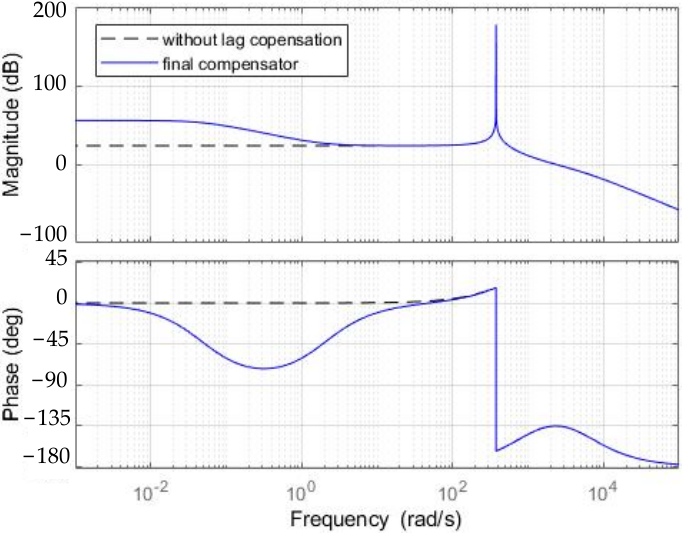
Figure 6. Bode plot of the compensator with and without lag compensation. The final compensator is: